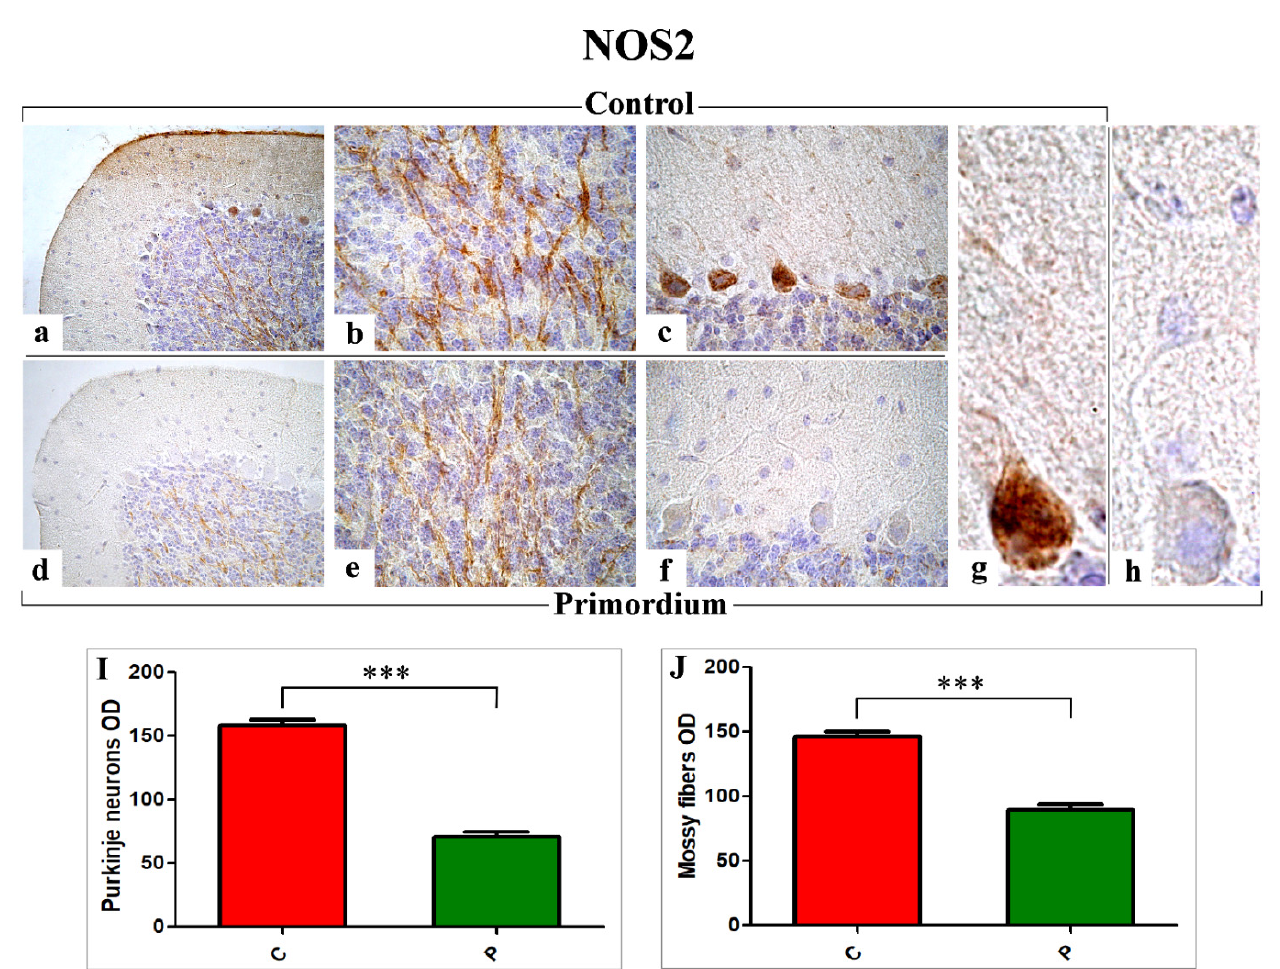
Figure 5. Immunohistochemical labelling for NOS2 in C ( a – c , g ) and P ( d – f , h ) mice. Panels I and J: Histograms showing the quantitative analysis of NOS2 immunoreaction evaluated as PCs and mossy fibers OD (( I ) and ( J ), respectively)). p values, calculated by unpaired t -test, were considered significant for p < 0.001 (***).